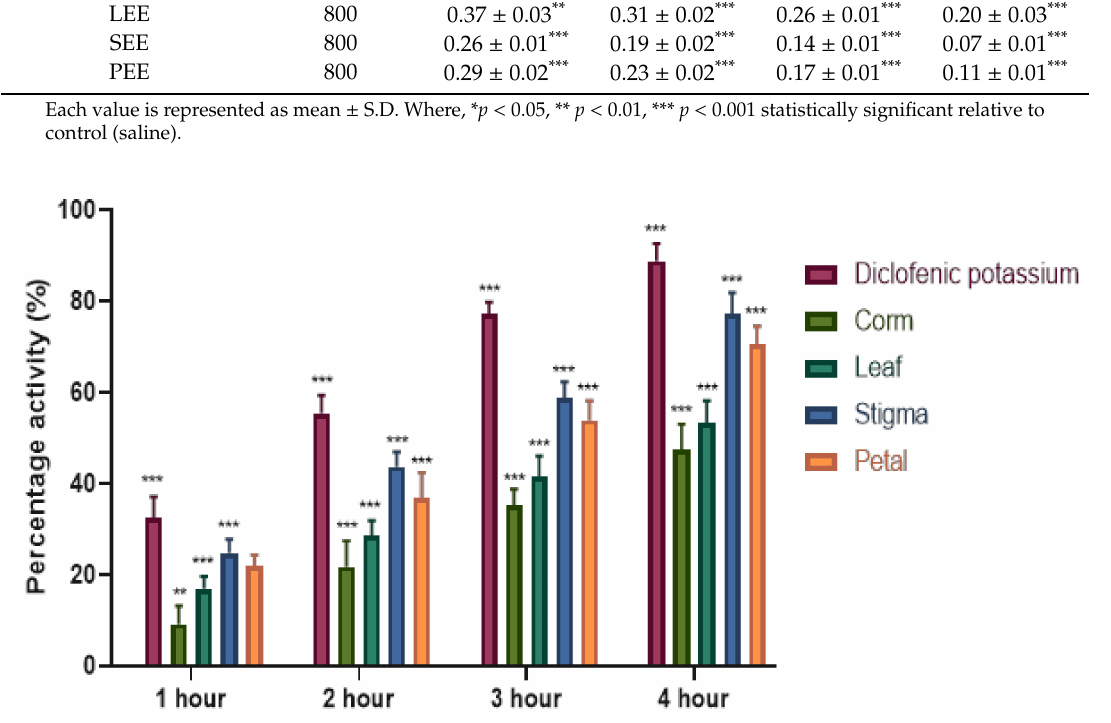
Figure 3. Percentage edema inhibition of C . sativus ethanolic extracts at selected time period in mice. Each value is represented as mean ± S.D. Where, * p < 0.05, ** p < 0.01, *** p < 0.001 statistically significant relative to control